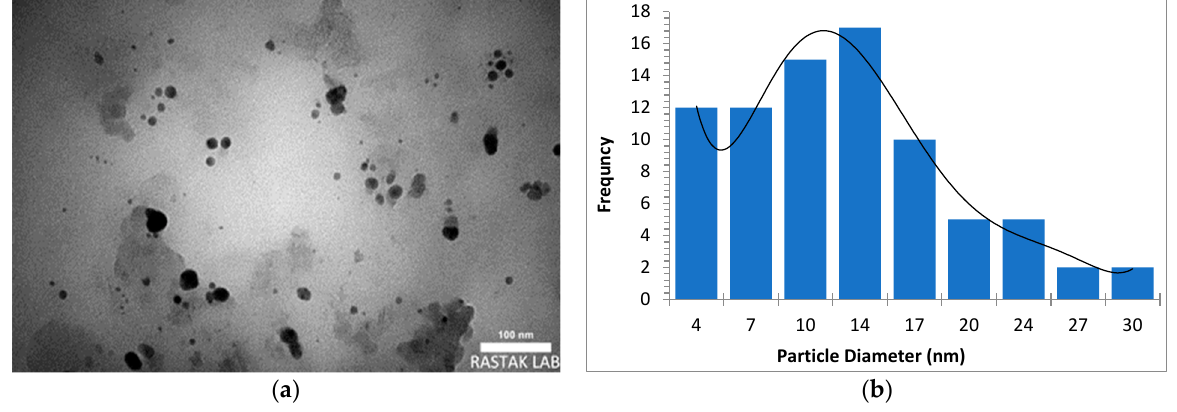
Figure 4. ( a ) TEM image of palladium nanoparticles (Pd NPs) prepared by pulsed laser ablation of palladium target in distilled water at 6.12 J/cm 2 , ( b ) size distribution.